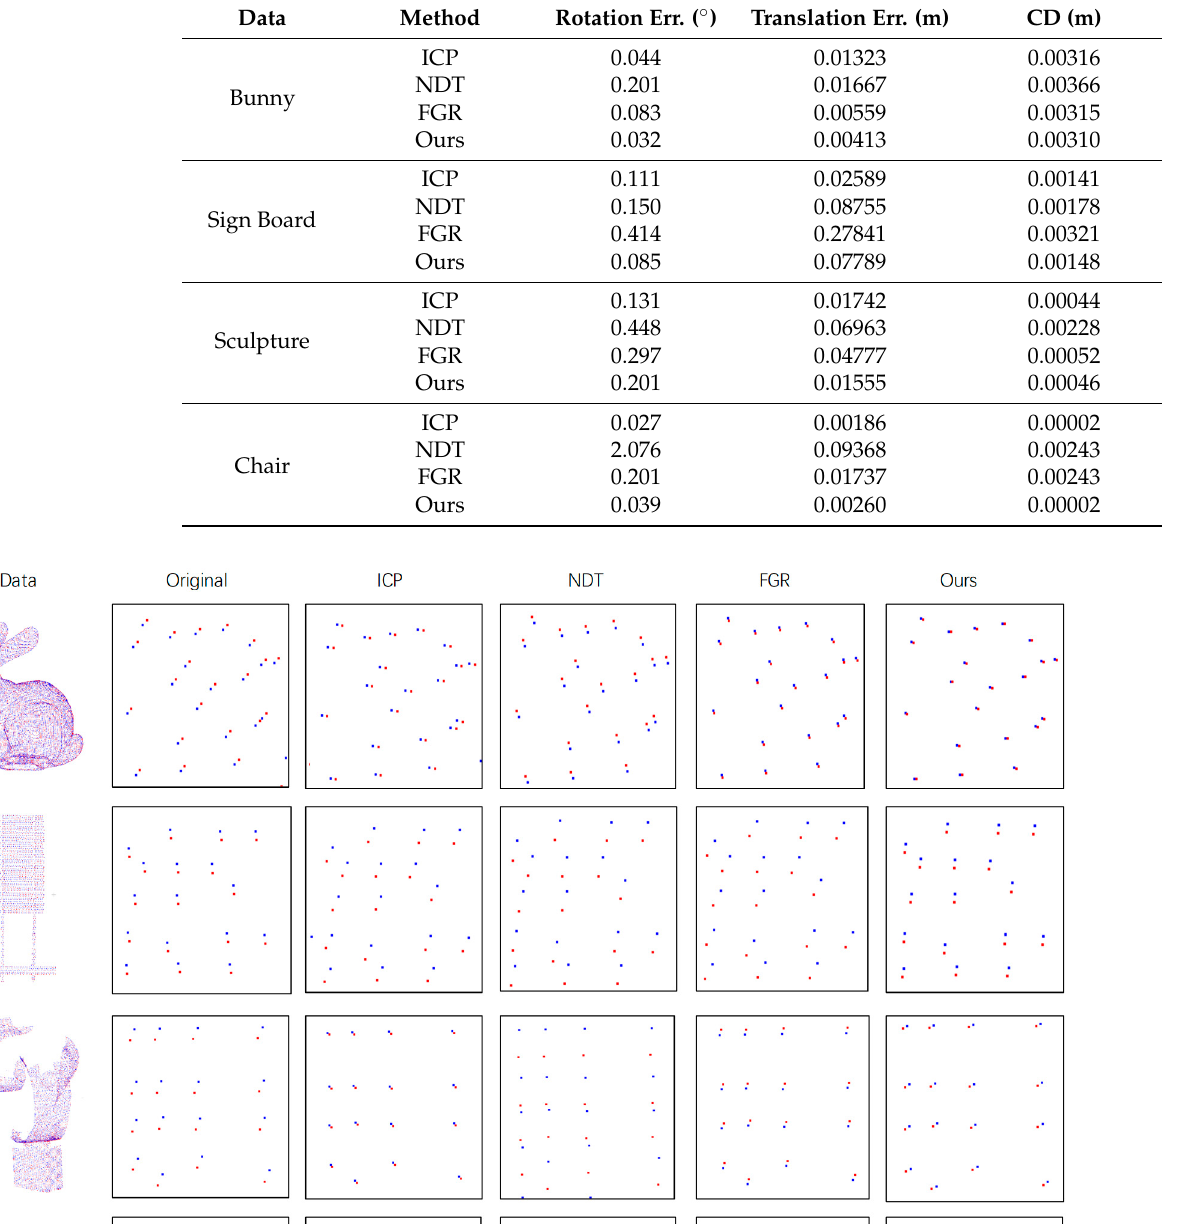
Table 2. Performance on Different Resolution Data.